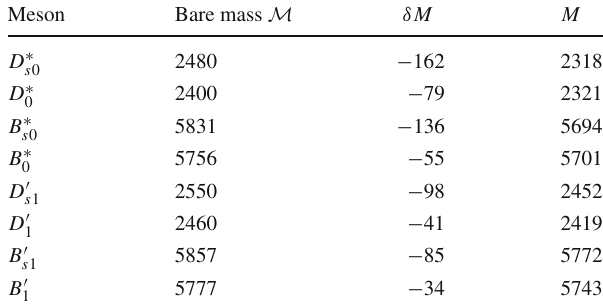
Table2 Massshifts( δ M ≡ M − M )ofheavyscalarmesonscalculated inHMChPT.Therenormalizationscaleistakentobe (cid:22) = 1 .